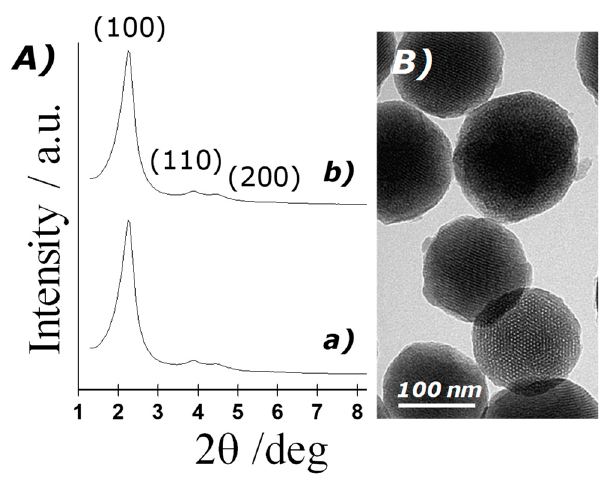
Figure 2. ( A ) Powder X-ray patterns of the solids: ( a ) MCM-41 as-synthesised and ( b ) calcinated MCM-41; ( B ) TEM images of calcinated MCM-41, showing the typical hexagonal porosity of the mesoporous matrix.